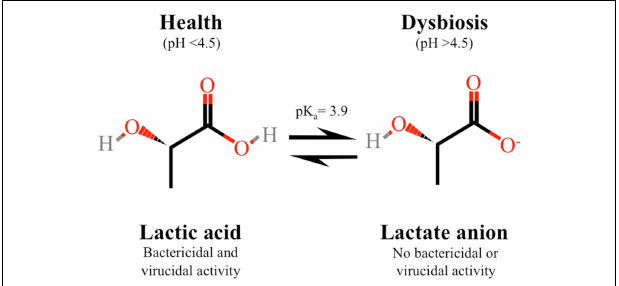
FIGURE 2 | Protonated lactic acid exists in equilibrium with the un-protonated lactate anion, which is determined by the acid dissociation constant (pK a 3.9). In healthy asymptomatic women of reproductive age with low vaginal pH, lactic acid predominates which is the microbicidal and virucidal form with immune modulatory activity. In contrast, the lactate anion, which does not have microbicidal or virucidal activity, predominates in women with bacterial vaginosis with a neutral vaginal